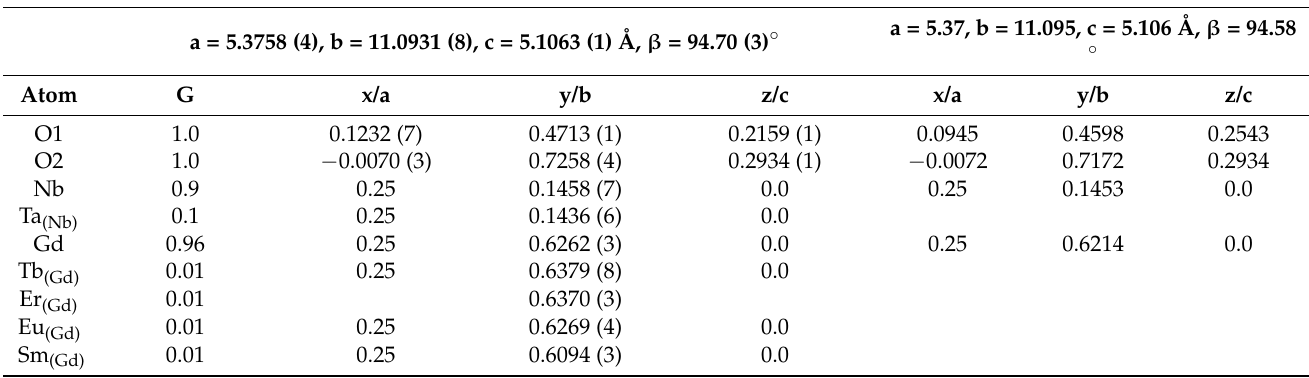
Table 4 shows results of WPPF refinement of the structure phases of Gd 0.96 Eu 0.01 Sm 0.01